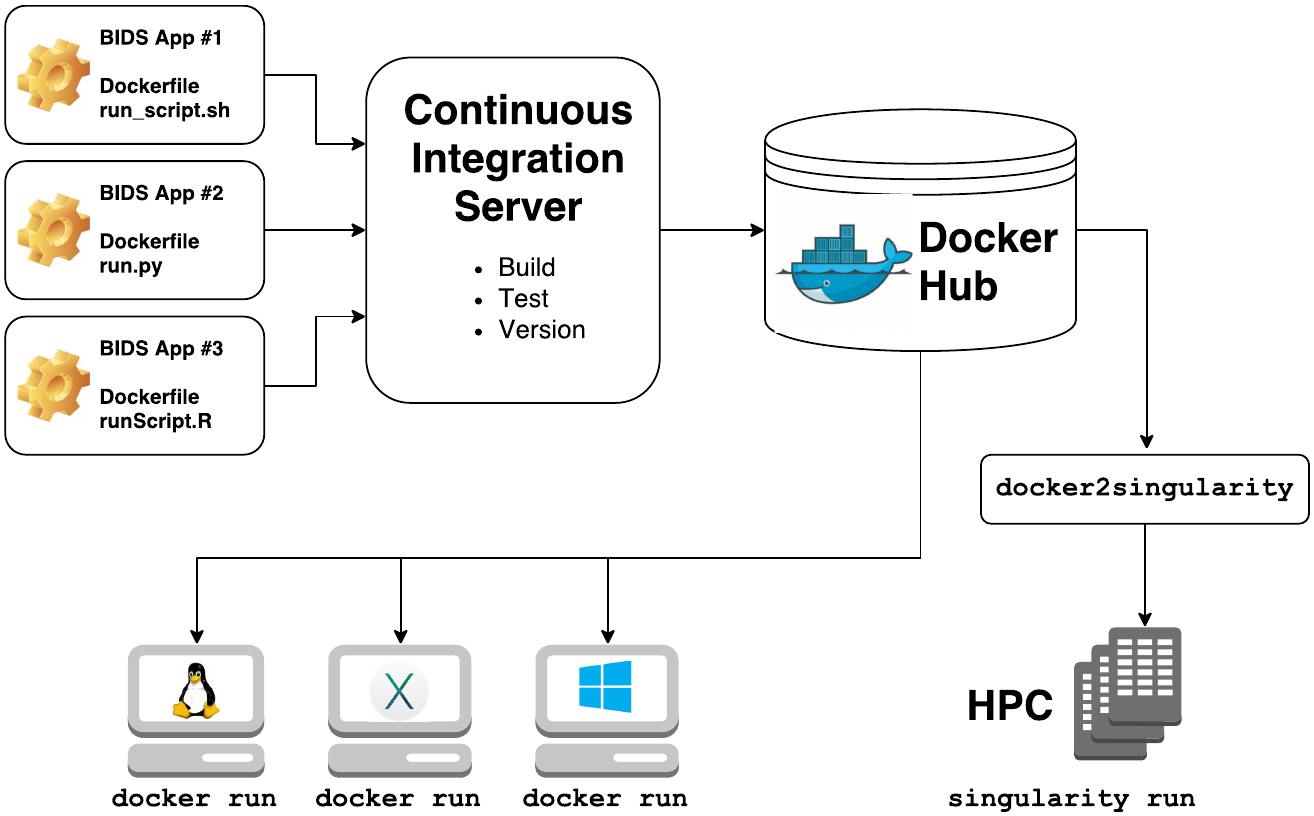
Fig 1. Overview of the creation and use of BIDS Apps. The source code of each App is stored in separateGitHub repository. Each repository is connectedto a Continuous Integration server responsible for buildingtesting and deployingthe corresponding App. For every new releaseof an App, a new containerimage is depositedin Docker Hub. Users can directly downloadand run the BIDS Apps containerimages either directly using Docker on any Windows, Mac, and Linux machineor convert them to Singularityand run them on an